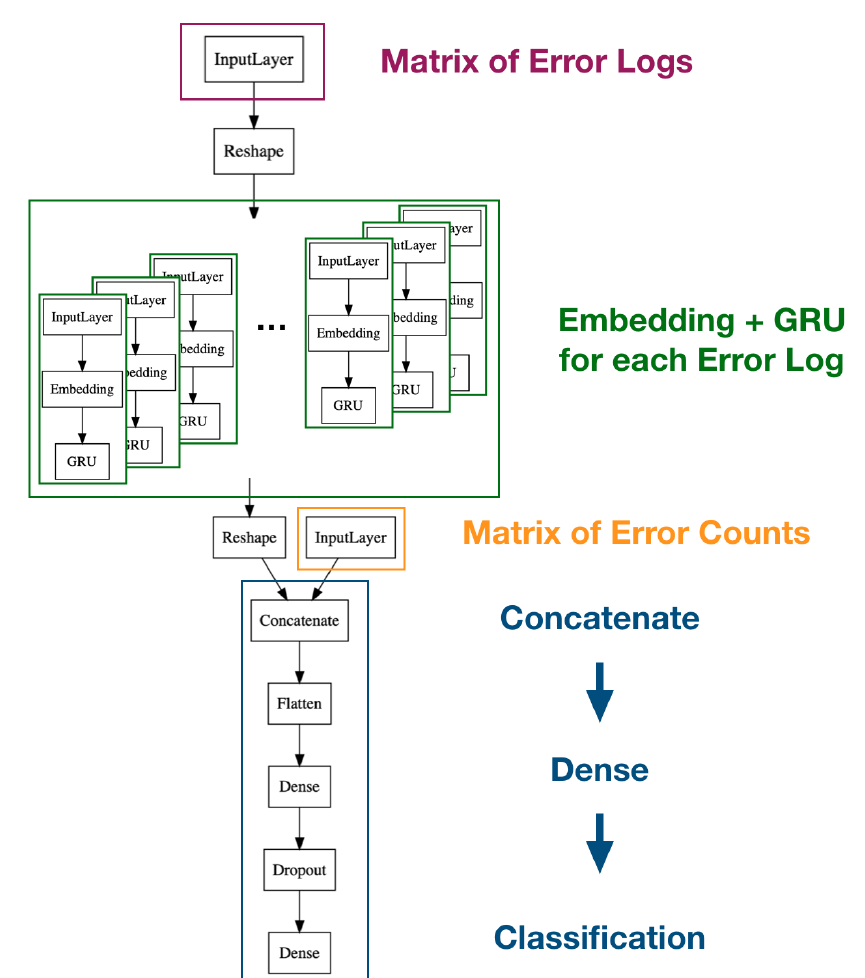
Figure 4: Sketch of a model that uses a GRU to encode the error log snippets of the sparse error-site matrix. Also the error count information is added. The final target is a binary